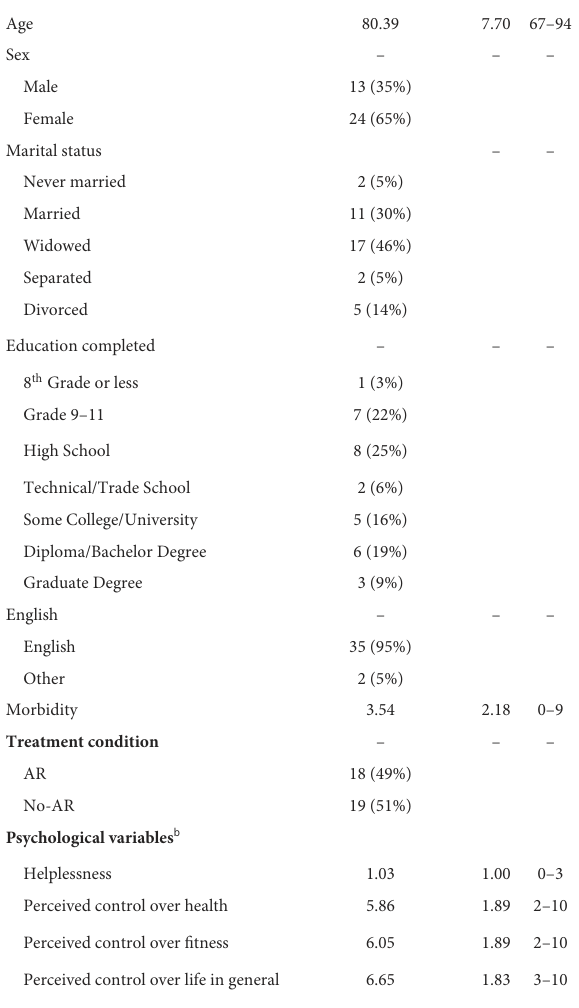
TABLE 1 Frequencies and descriptive statistics for demographic and psychological